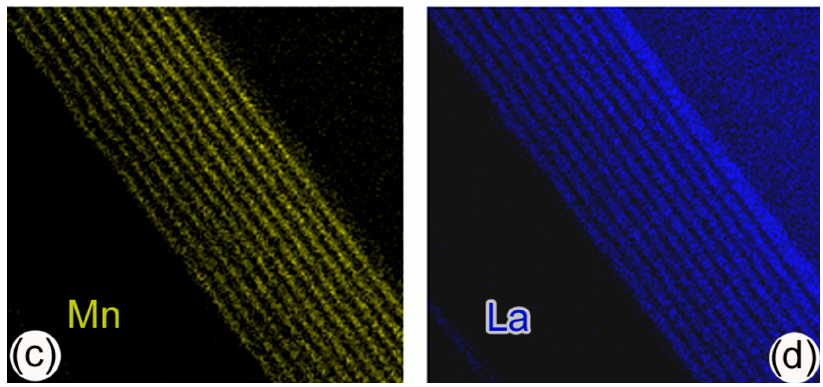
Figure 2. ( a ) HAADF image and ( b – d ) are the element mapping images of Fe, Mn, and La of sample-I, respectively.